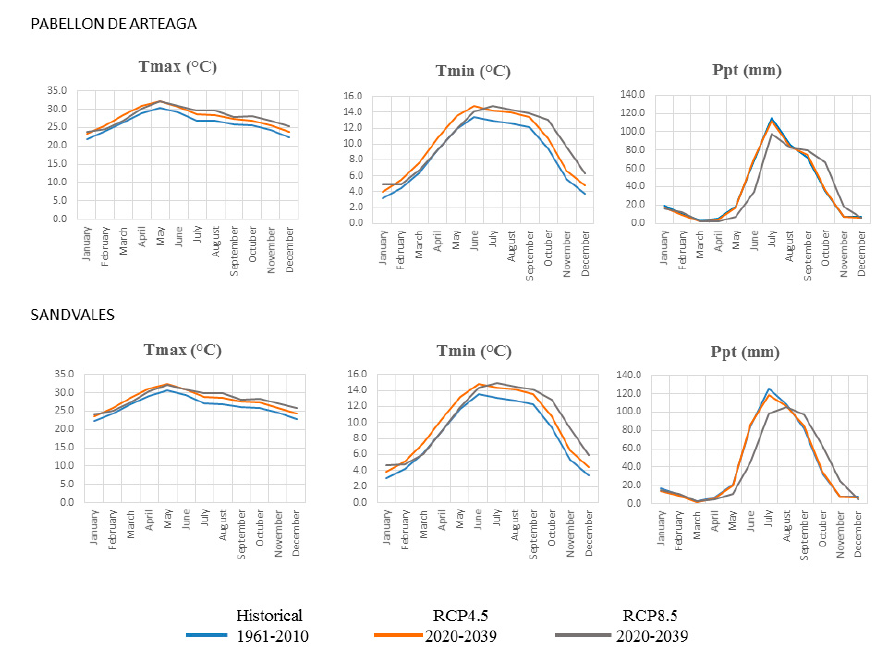
Figure 3. Historical and forecasted monthly maximum (Tmax) and minimum (Tmin) temperature and precipitation (Ppt) under the climatic change scenarios RCP4.5 and RCP8.5 for the period 2020–2039 for common beans under rainfed condition in the semi-arid temperate highlands of Pabellon de Arteaga and Sandovales in Aguascalientes,